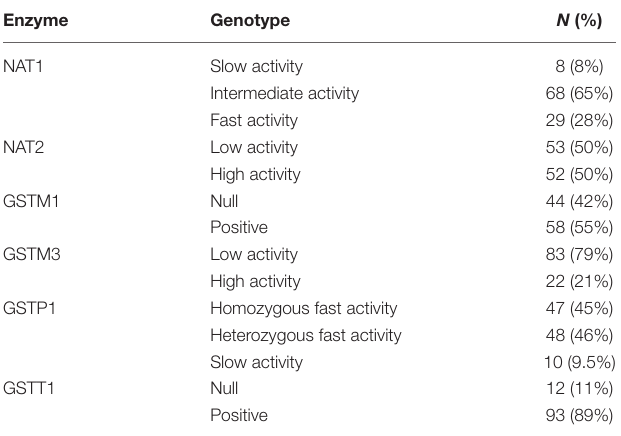
TABLE 2 | Distribution of the NAT and GST genotypes among the study subjects.